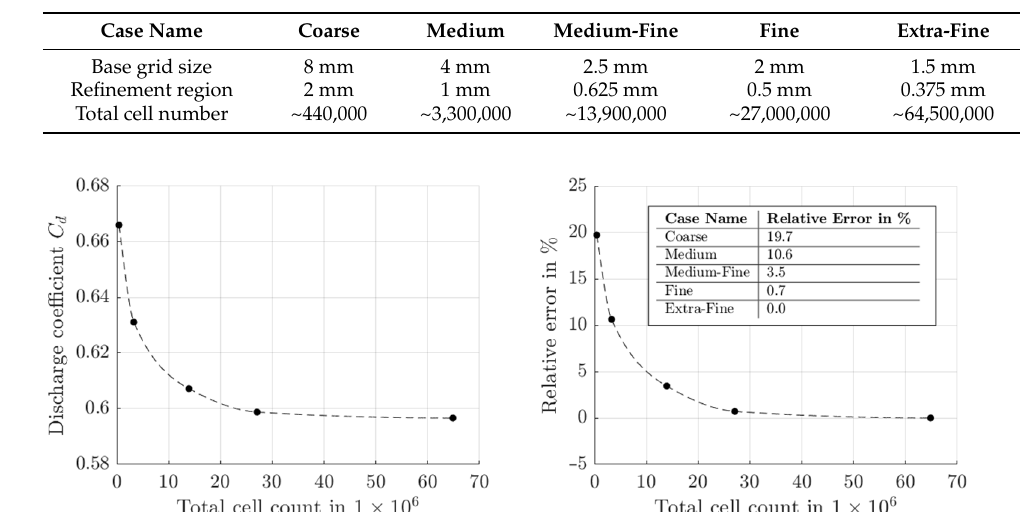
Table 2. Test matrix for different grid sizes.